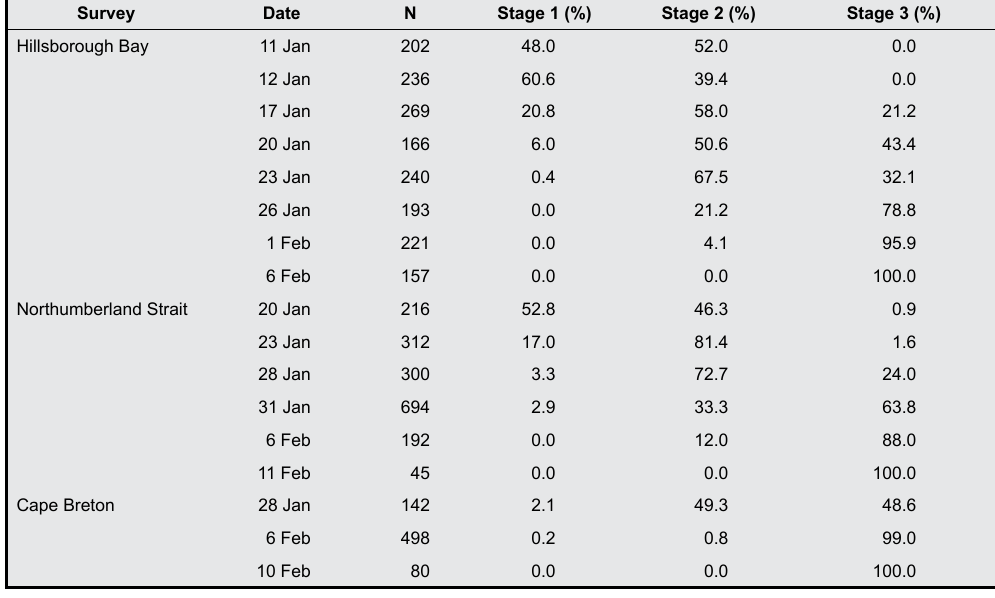
Table 7. Proportion of pups in various age-dependent developmental stages during 2000 surveys.